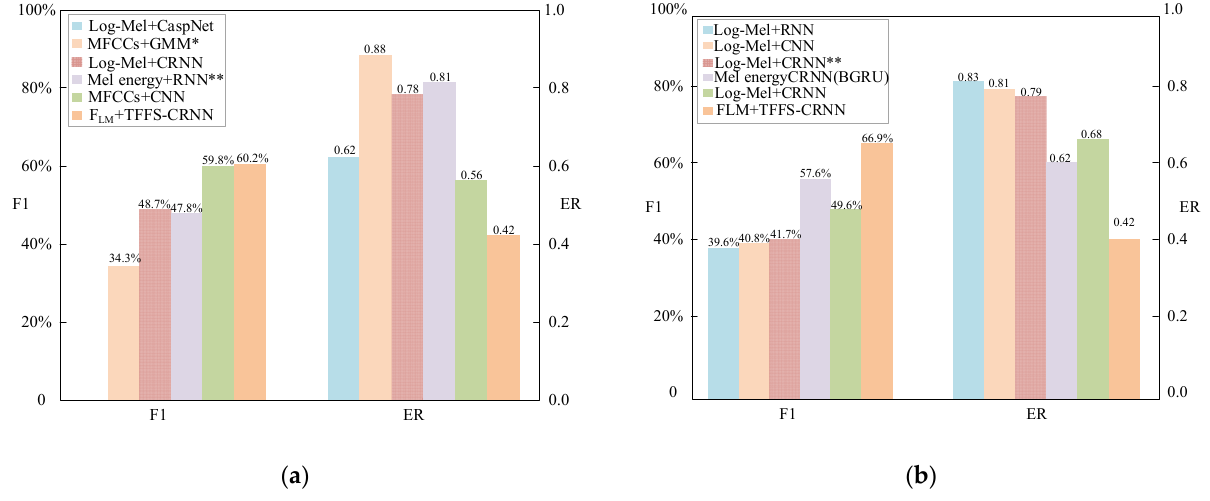
Figure 7. The results of different methods in the evaluation dataset. The figure ( a ) is the experi- mental result of the DCASE 2016 Task3 dataset; the figure ( b ) is the experimental result of the DCASE 2017 Task3 dataset. Task3